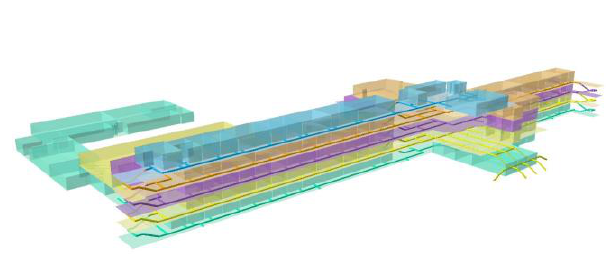
Figure 3. 3D Visualization of the Melchor Hall in ArcScene showing the extruded rooms and the indoor paths